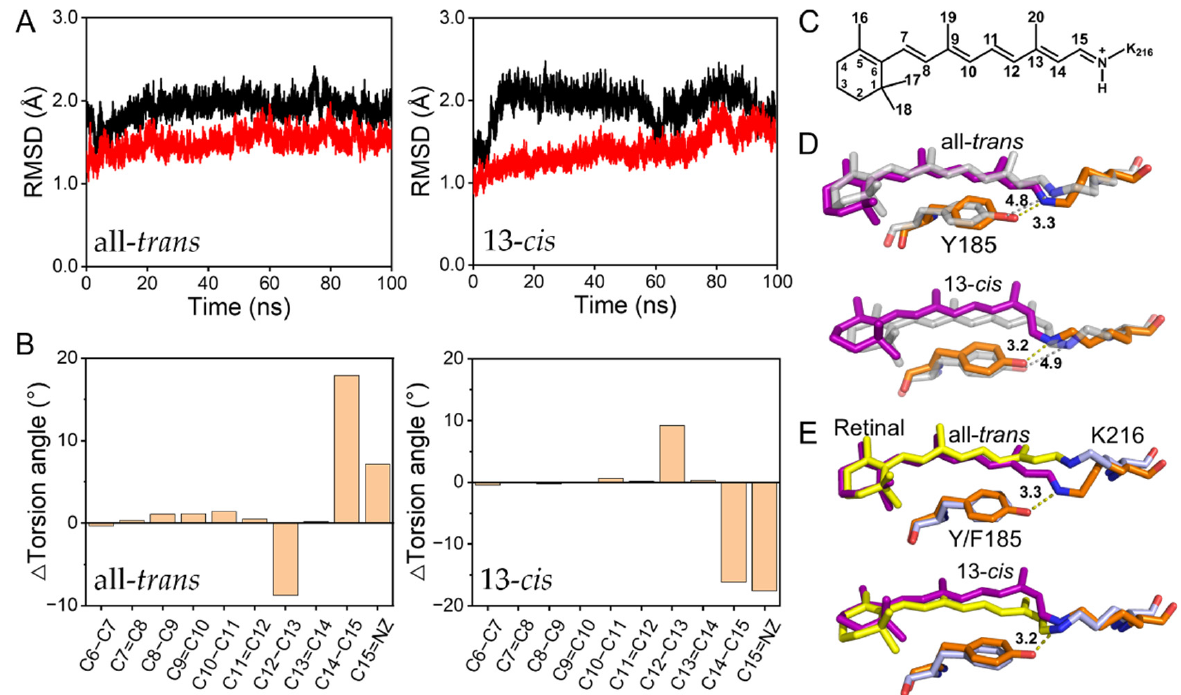
Figure 2. Changes in protein stability, the retinal sidechain torsion angle, and interaction with Y185/F185 in WT-bR and Y185F. ( A ) Time evolutions of root–mean–square deviation (RMSD) of the C α atoms of the dark-adapted wild-type (black line) and Y185F mutant (red line); the left is bR trans , and the right is bR cis . ( B ) The difference in the retinal sidechain torsion angle of Y185F minus WT-bR in the bR trans and bR cis , respectively. ( C ) Molecular structure of the retinal Schiff base. ( D ) Crystal (grey, PDB 1C3W for bR trans and 1X0S for bR cis ) and simulated (purple and orange) structure comparisons of Y185 with the Schiff base in bR trans and bR cis . ( E ) The superimposed Y185/F185 with the retinal Schiff base in WT-bR (purple and orange) and Y185F (yellow and light blue) by MD simulations.